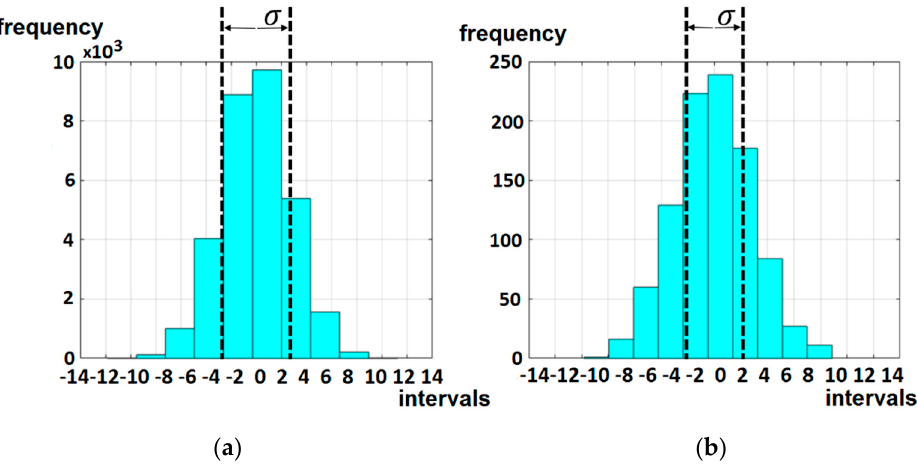
Figure 6. Histograms of tree nodes, Coiflets 3: ( a ) node (2, 1); ( b ) node (5, 1).